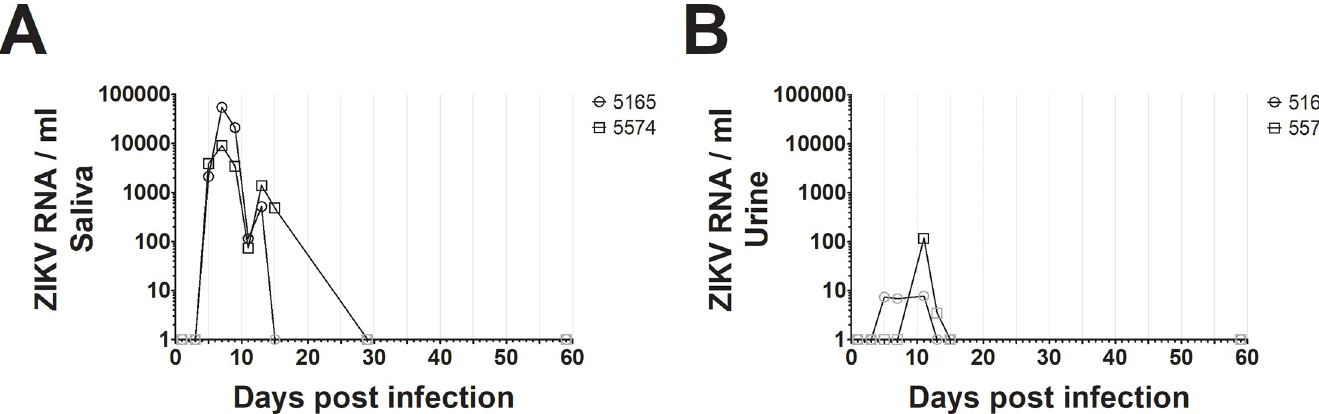
Fig 3. ZIKV was quantified in saliva (A) and urine (B) samples from experimentally infected non-human primates using SYBR-green RT-qPCR. ZIKV was detected between days 5–15 in saliva, and on day 11 in urine. These data are representative of two experiments from independent RNA extractions. Gray symbols indicate ZIKV at levels outside the range of the standard curve. No ZIKV was detected at 59 dpi in either saliva or urine.